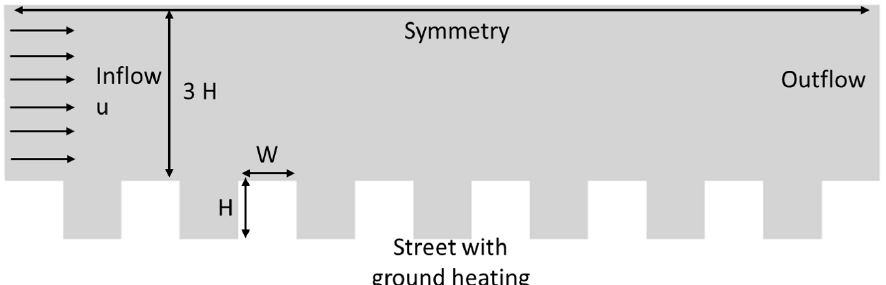
Figure 1. Seven street canyons with bottom heating in the middle street.